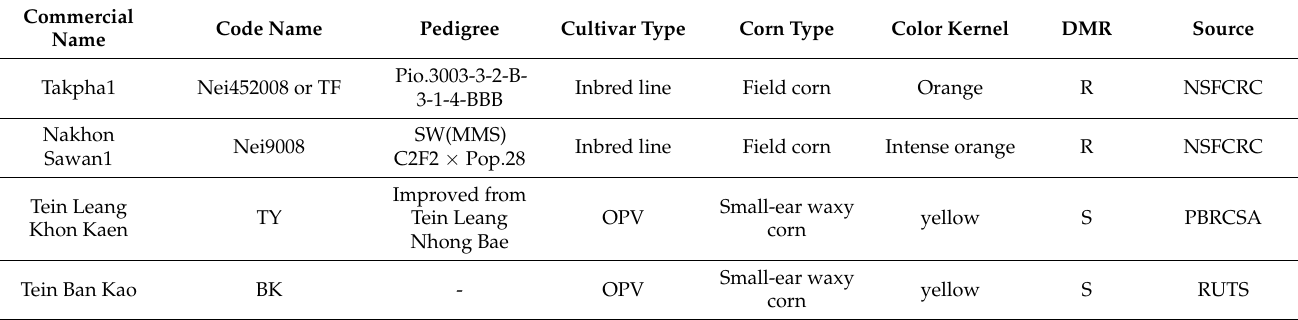
Table 1. Pedigree, type of varieties, color kernel, DM resistance, and sources of genetic materials used in this